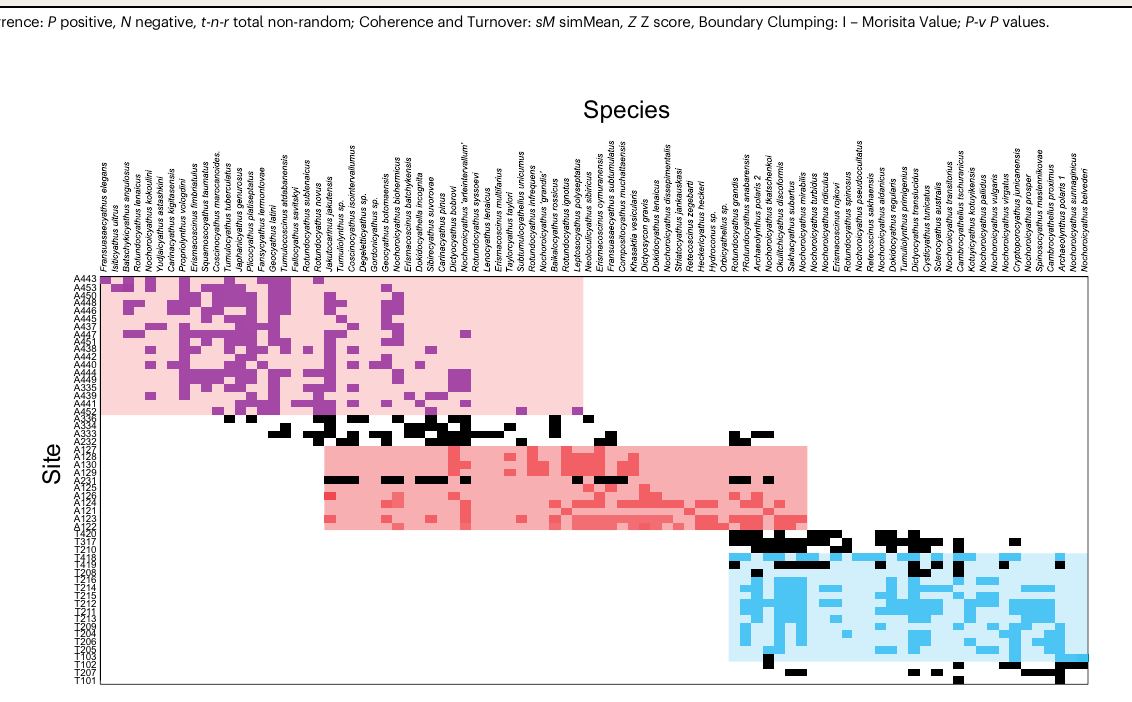
(A4; purple). Black squares are sites that do not fi t into our T2, A1 and A4 groups, because there are an insuf fi cient number of sites to perform analyses within these time intervals. The least ecologically complex metacommunity (Gleasonian) is indicatedbythepalebluebackgroundshading,themostcomplex(Clementsian)by the red-purple background and intermediate complexity (quasi-Clementsian) by the pale red background. The pattern within each of these blocks, rather than patterns within each site (rows), indicates the degree of